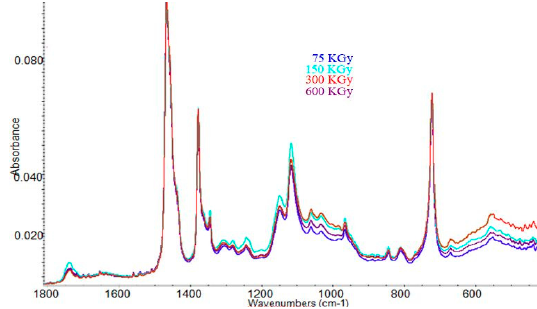
Figure 14. The infrared spectra for EPDM samples with 20 phr hemp fibers irradiated at different doses (from 75 to 600 kGy).